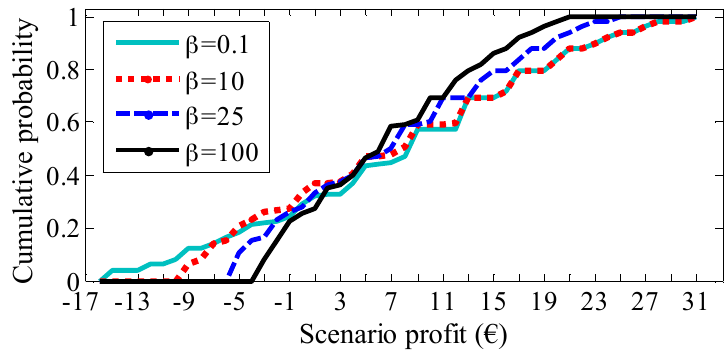
Figure 2 . Cumulative distribution functions with varying β at hour 4:00. Figure 7. Cumulative distribution functions with varying β at hour 4:00.